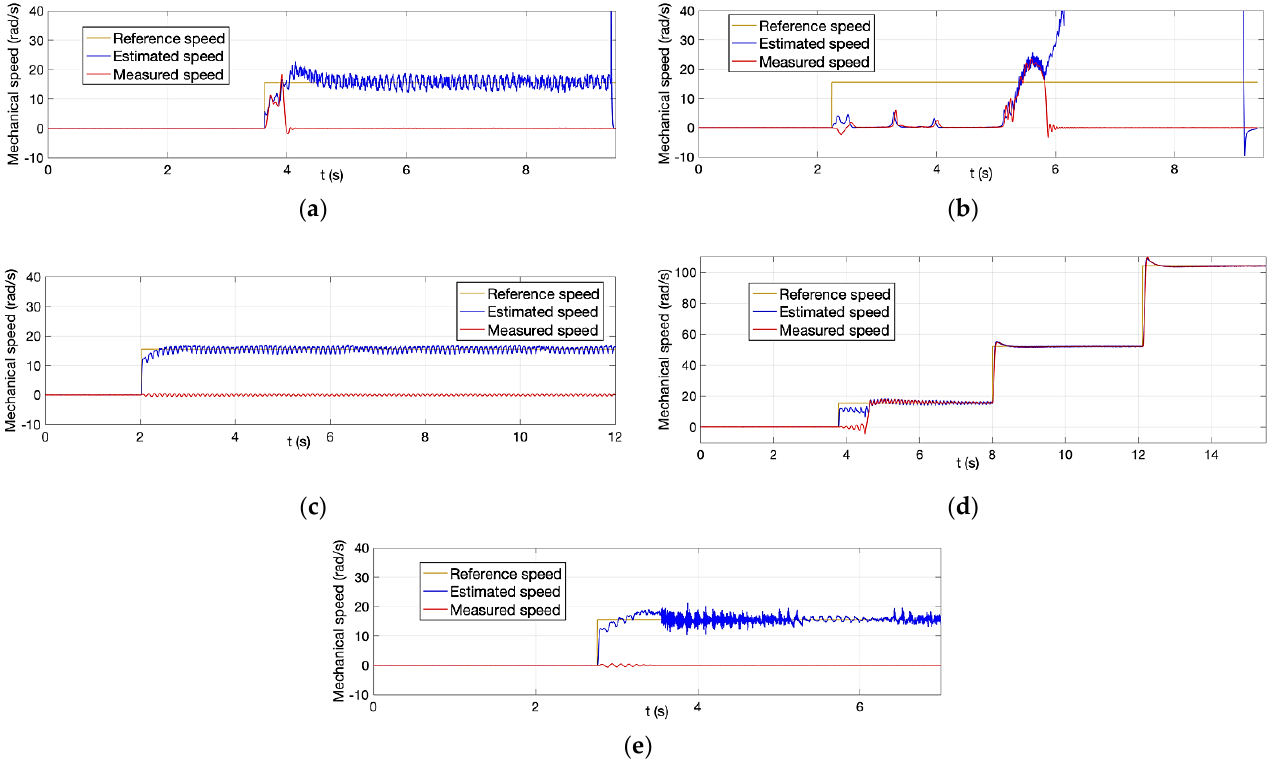
Figure 15. Reference, estimated and measured speed during starting with full load applied: ( a ) ELADRC algorithm; ( b ) FACCF-SMO algorithm; ( c ) nonlinear RFO; ( d ) adaptive RFO; ( e ) regression RFO.